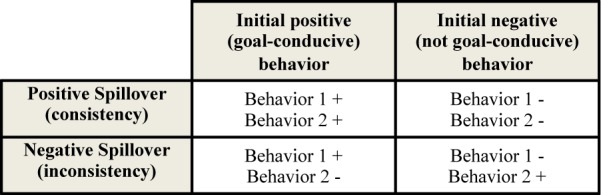
Overview of how the valence and (in)consistency of successive behaviors lead to positive and negative spillover (adopted from Dolan and Galizzi, 2015).